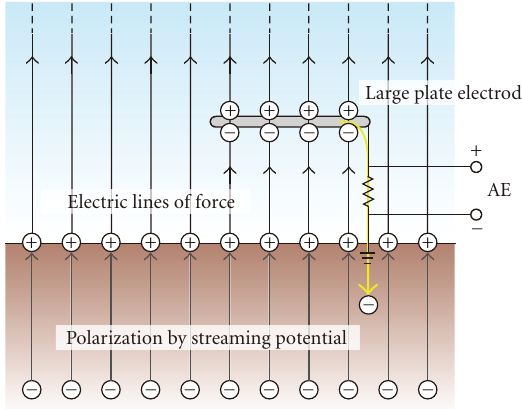
Figure 8: Generation model of induced atmospheric electricity (AE) coupled with generation of streaming potential in the